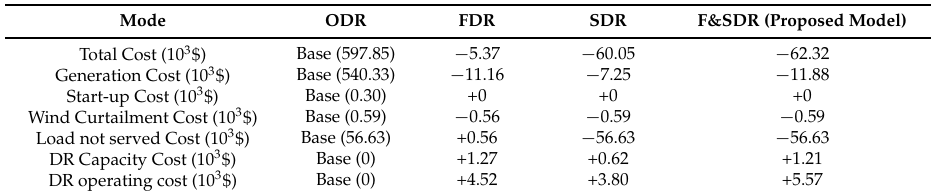
Table 3. DR scheduling modes impact on cost when the wind power output is wind power profile 1: without transmission constraints.